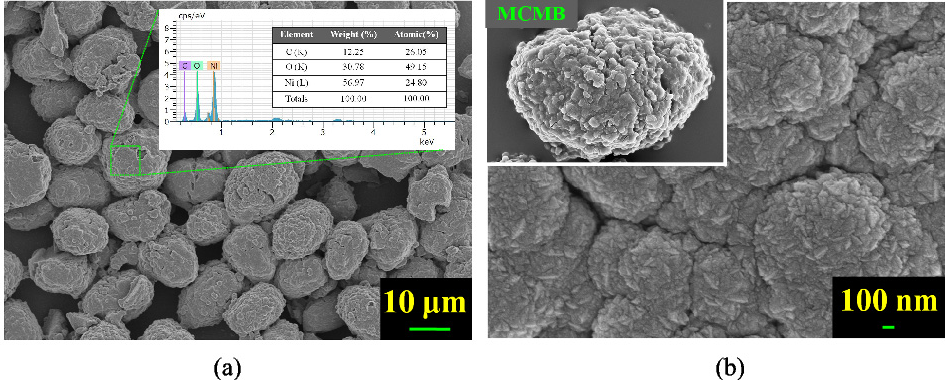
Figure 3. SEM morphologies and EDS of the NiO thin films deposited on the carbon electrode: ( a ) the magnification of 1000× ( b ) the magnification of 30,000×.